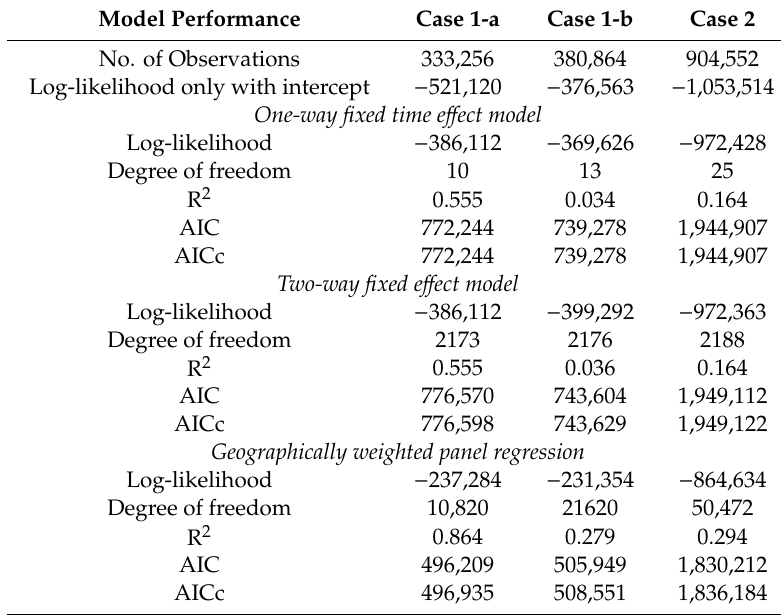
Figure 2. Spatial autocorrelations among residuals. Table 2. Model performance of panel models and GWPR.